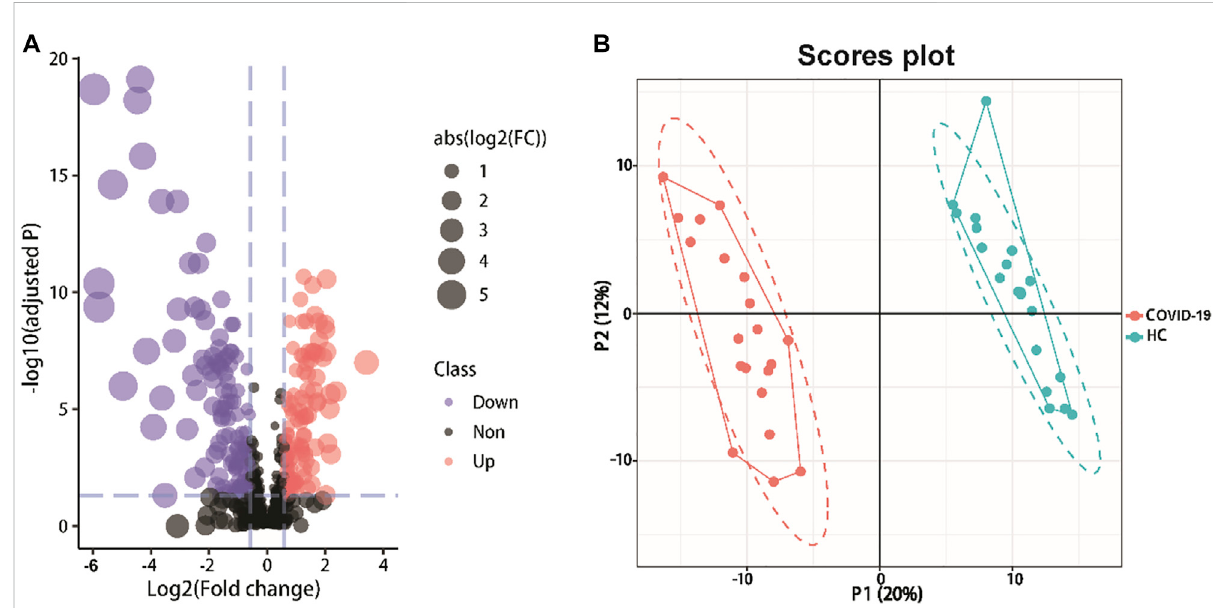
FIGURE 2 Detected metabolites analysis of serum samples from COVID-19 patients and healthy controls. (A) Volcano plots show the change in transformedP-adjust( − log10) against thelog2 (COVID-19/Healthy). Blue dashed lines: cut-off values (ratio > 1.5 and p -value adjust < 0.05). Red dots: Highlyexpressedmetabolites inCOVID-19patients(115).Purpledots:Lowexpressionofmetabolites (128).Thesizeofthepointsvariesaccordingto the absolute value of [Log2(COVID-19/Healthy)]. (B) PLS-DA plot of differentially abundance metabolites. Red and blue points are COVID-19 patients and healthy controls, respectively (R2 = 0.994, Q2 =